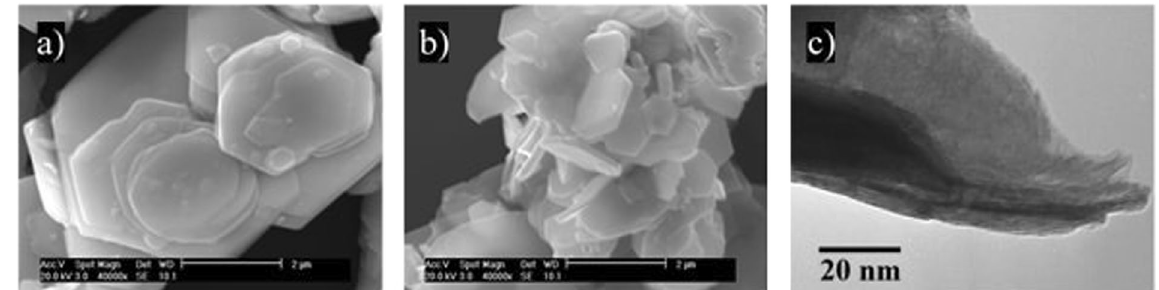
Figure 2. SEM ( a , b ) and TEM ( c ) images of commercial 2H-WS 2 particles.